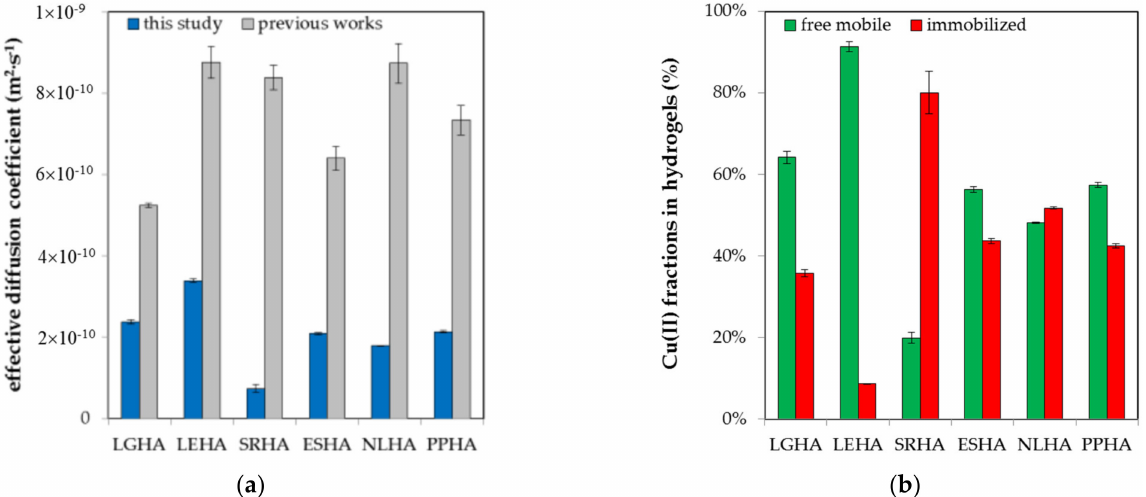
Figure 2. Results of diffusion experiments: ( a ) The comparison of effective diffusion coefficients determined in this study (blue) and previous works (grey); ( b ) The content of free mobile (green) and immobilized (red) fraction of Cu (II) ions in hydrogels enriched by humic